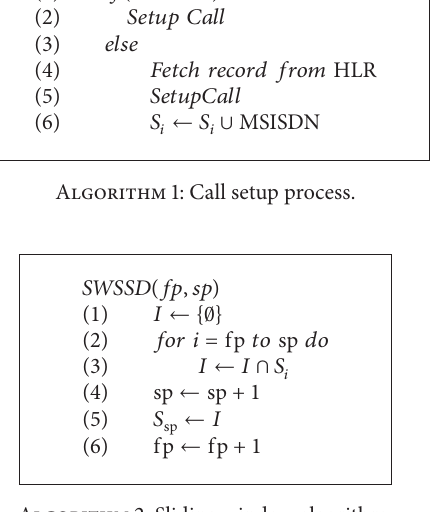
Algorithm 2: Sliding window